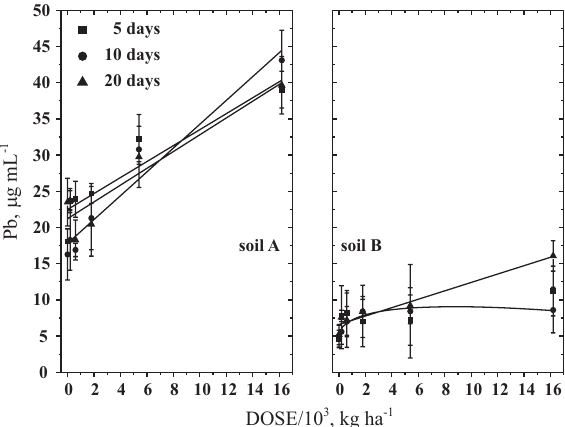
Figure 6. Lead extractability under increasing doses of solid residue in soils A and B. Table 3 shows the fitted parameter values according to the algebraic model adjusted to Pb response.